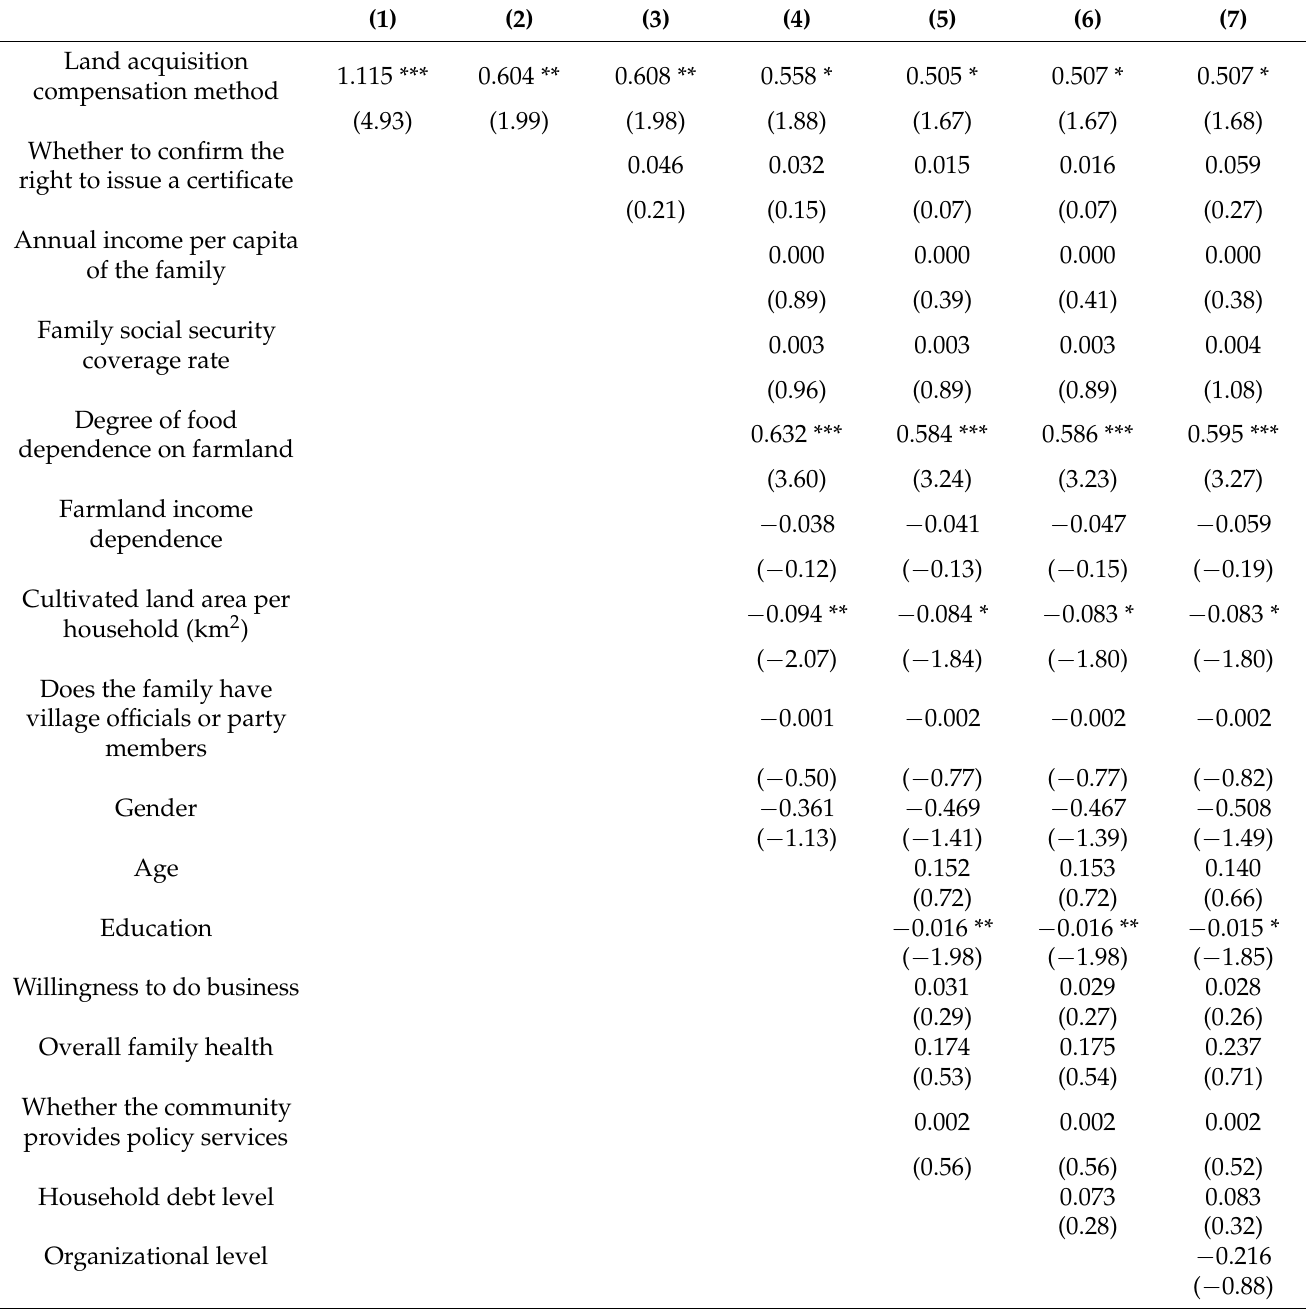
Table 7. The analysis of heterogeneity of compensation